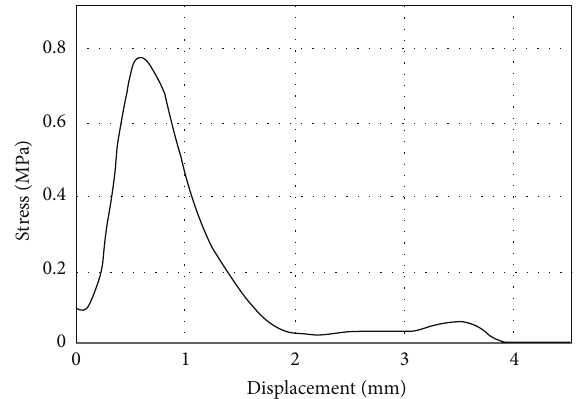
Figure 8: The compressive strength test curve of LGJ-70/10.